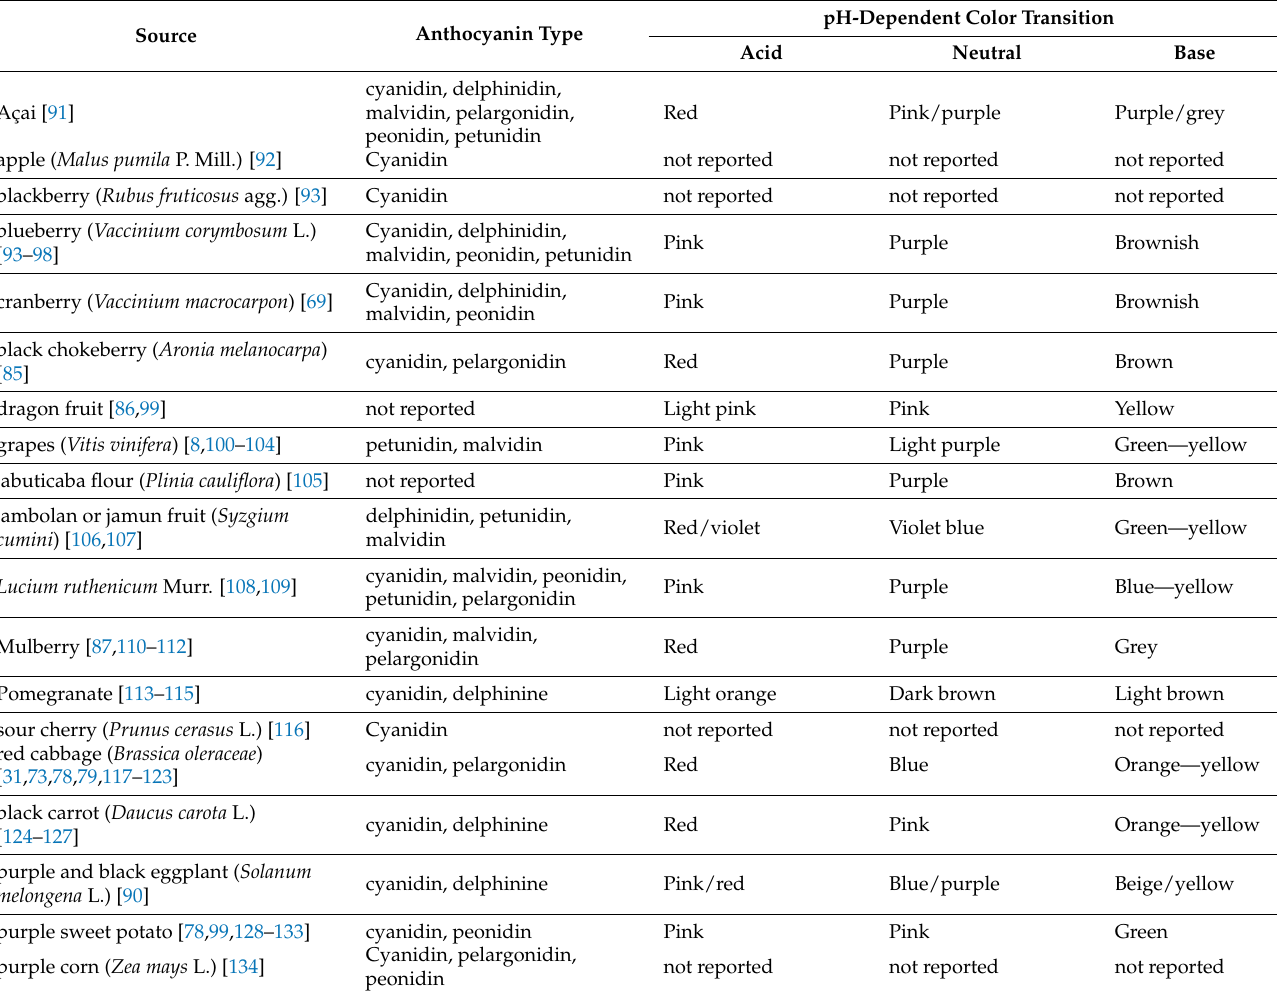
Table 1. Sources of anthocyanins, their types, and color behavior from representative studies focused on food packaging applications